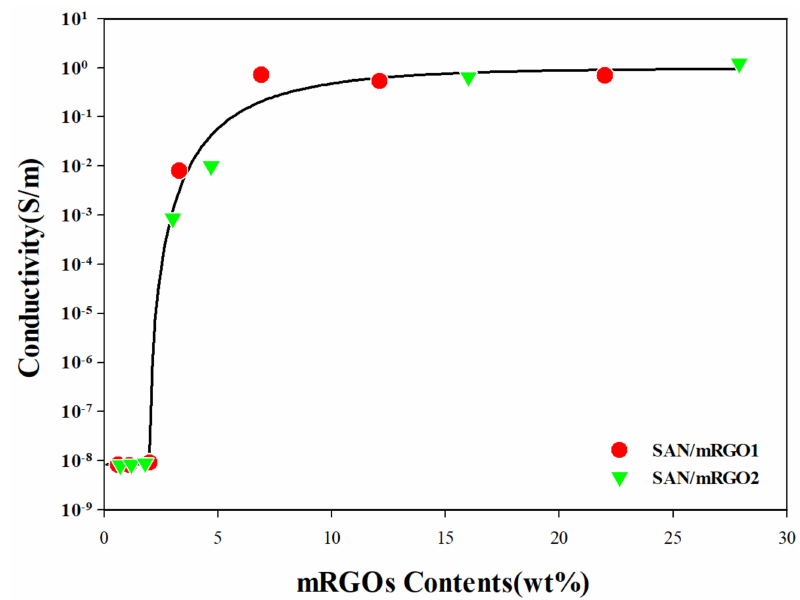
Figure 6. Electrical conductivity of SAN–mGO, SAN–mRGO1 and SAN–mRGO2 at various contents of mRGOs.